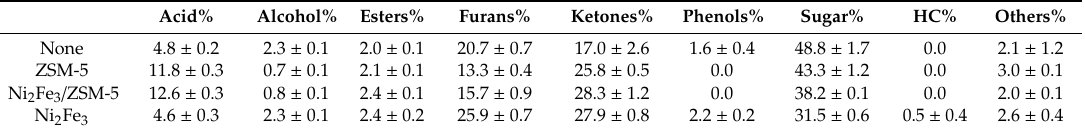
Table 1. Composition of cellulose pyrolyzed products with different catalysts (peak area% of identified peaks, unidentifiable compounds are lumped together in the others category).